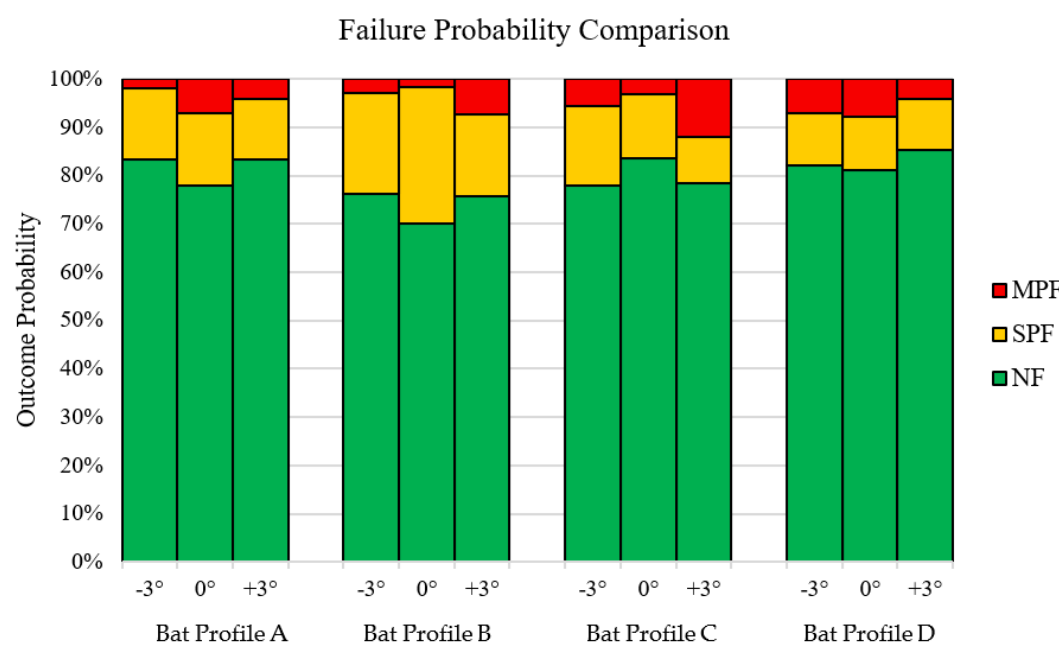
Figure 7. Probability analysis results of each bat profile by SoG.